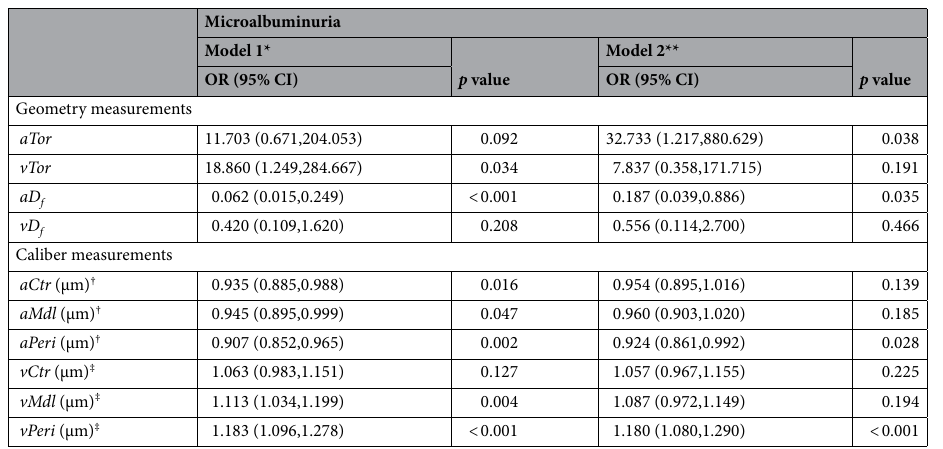
Table 2. Adjusted odds ratios of microalbuminuria in relation to retinal vascular measurements as continuous variables. *Model 1 adjusted for age and sex. **Model 2 adjusted for age, sex, duration, smoking, BMI, HbA1c, SBP, DBP, total cholesterol, triglyceride, high-density and low-density lipoprotein. † Arteriolar caliber measurements were further adjusted for vCtr , vMdl , and vPeri . ‡ Venular caliber measurements were further adjusted for aCtr , aMdl , and aPeri